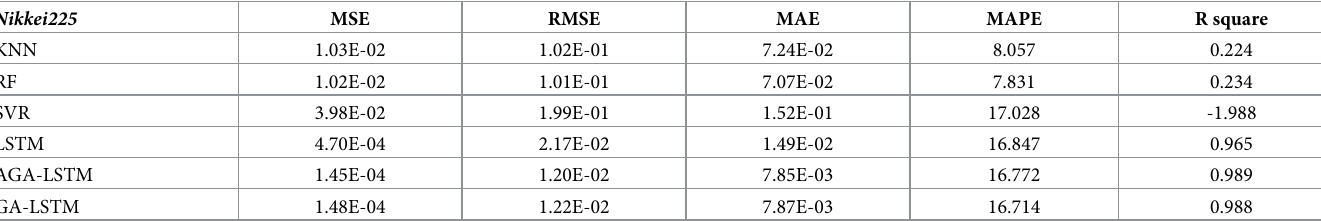
Table 10. The evaluation indexes of AGA-LSTM model and other DL models in Nikkei225 date set.